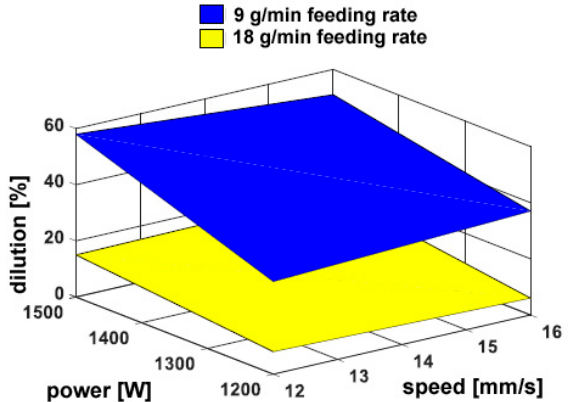
Figure 13. Dilution as a function of the governing variables; edge deposition.